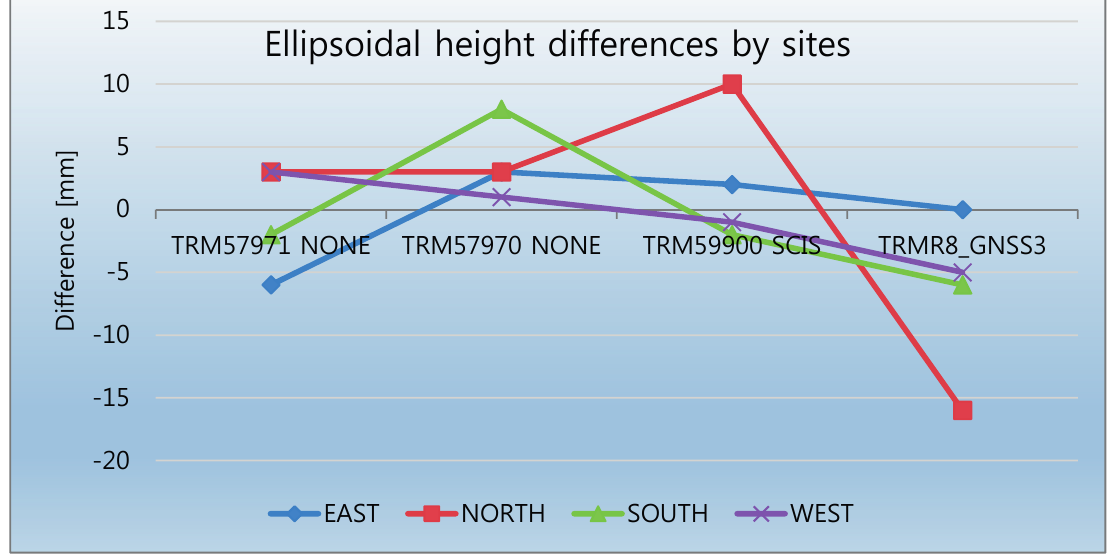
Figure 6. Differences in ellipsoidal heights by site (Phase 1) with respect to the mean OPUS-Projects